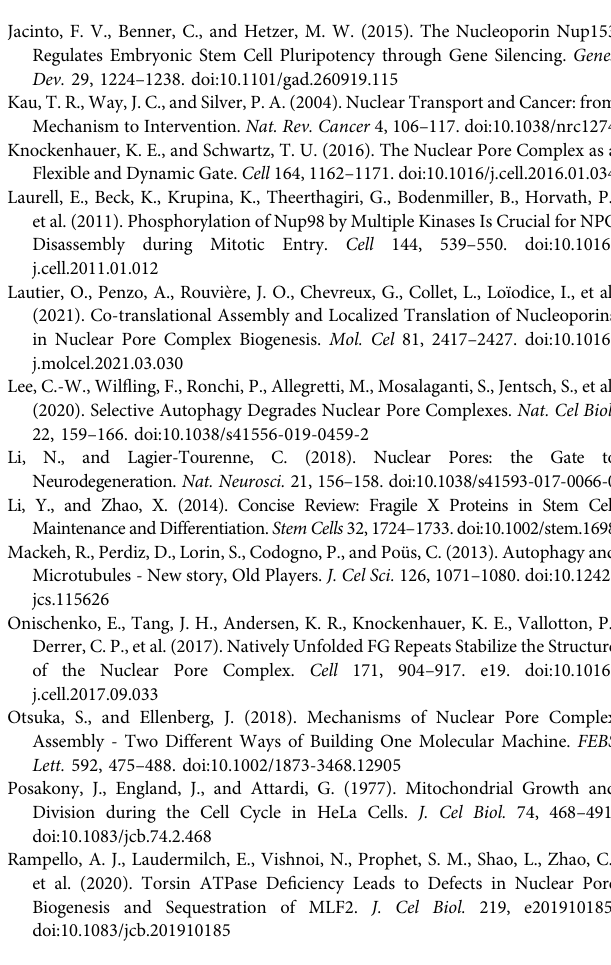
selected frames are shown in Figure 4C